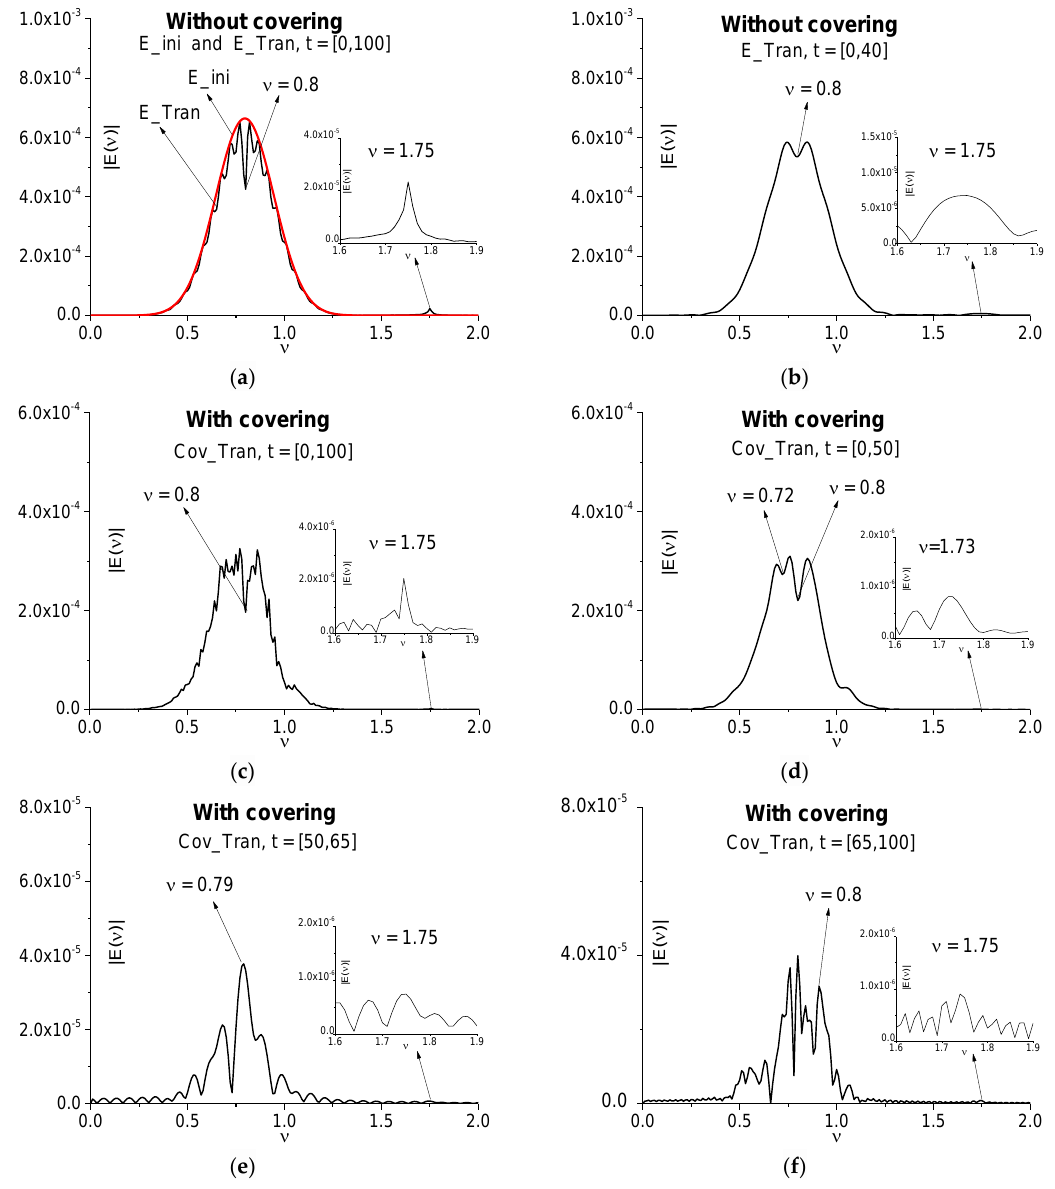
Figure 17. Fourier spectra of the signals transmitted through the uncovered medium (E_Tran) ( a ), ( b ) and medium with covering (Cov_Tran) ( c )–( f ) in the time intervals t = [0, 100] ( a ), ( c ), [0, 40] ( b ), [0, 50] ( d ), [50, 65] ( e ), [65, 100] ( f ).